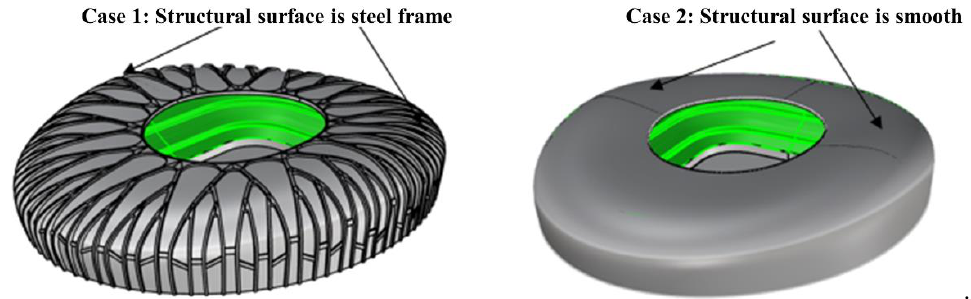
Figure 14. Diagram of working cases.